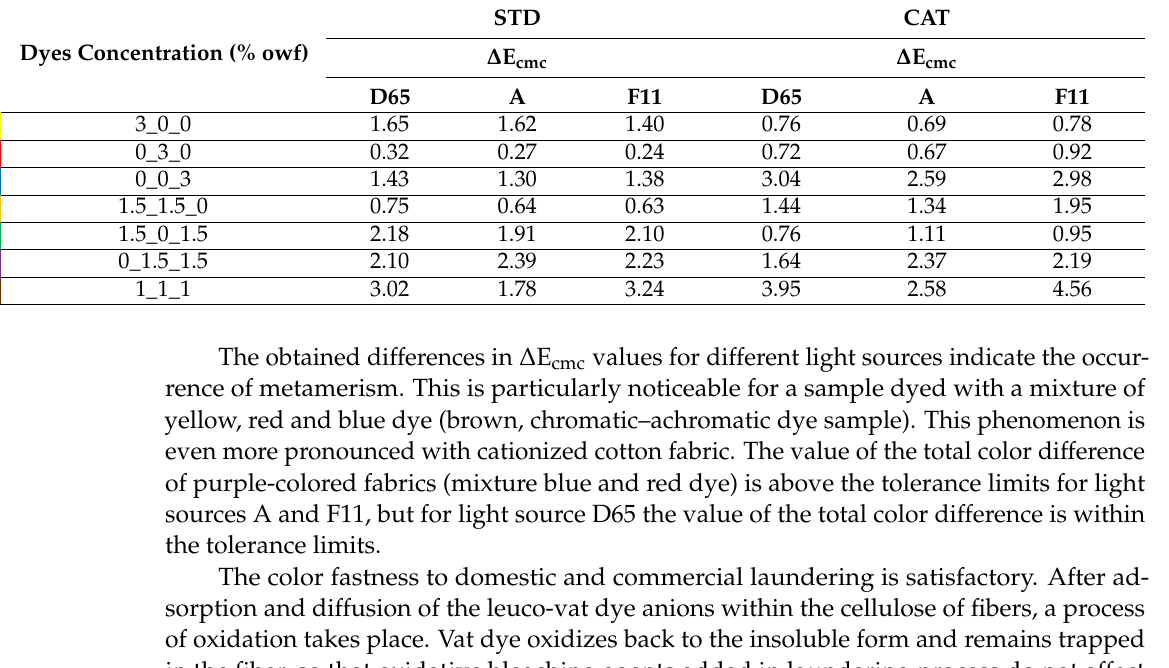
Table 5. Total color difference ( ∆ E CMC ) between washed and unwashed standard (STD) and cationized (CAT) fabric dyed with 3% owf dye at different light sources. STD Dyes Concentration (% owf)